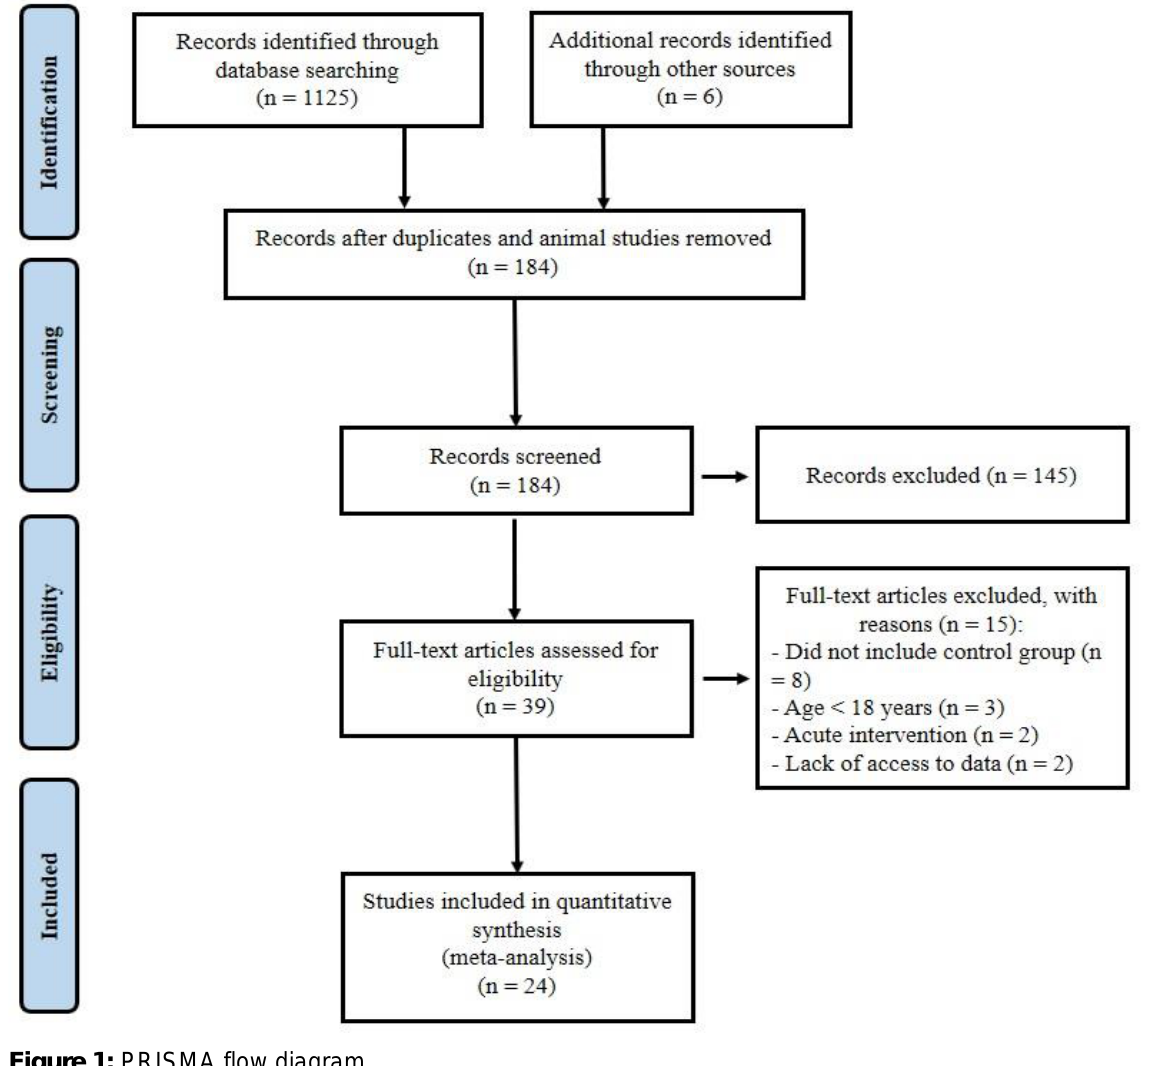
Figure 1: PRISMA flow